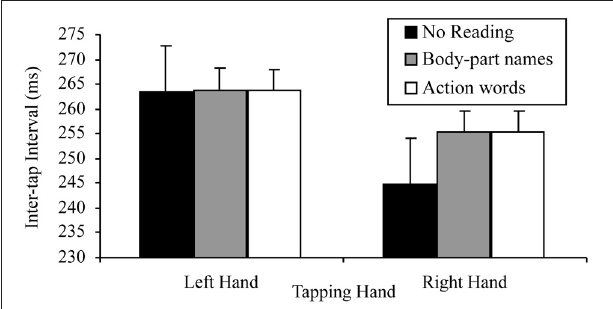
FIGURE 7 | Mean inter-tap intervals of each hand under the different reading conditions in the combined data set (error bars represent one standard error of the